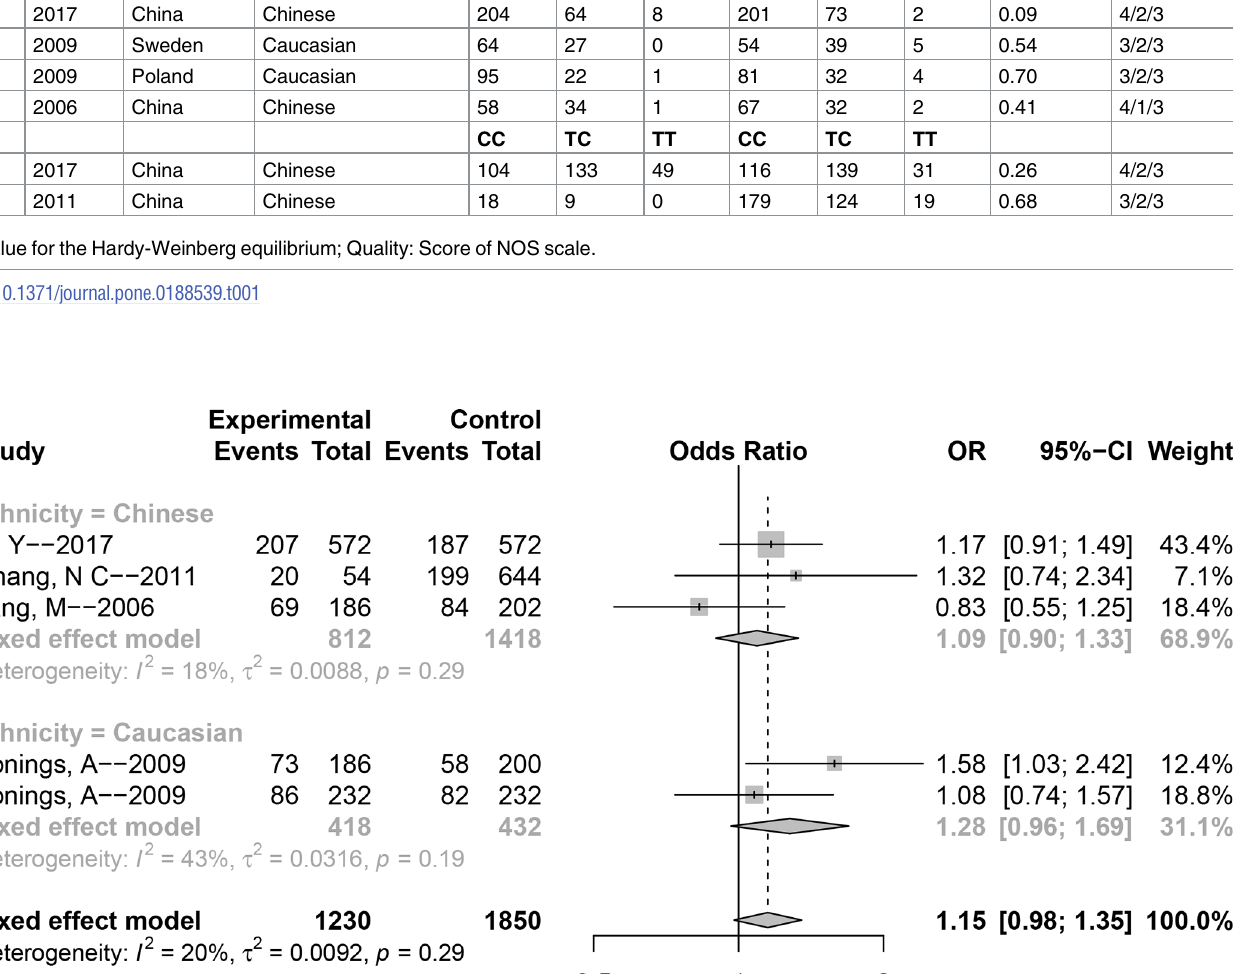
PLOS ONE | https://doi.org/10.1371/journal.pone.0188539 November27,